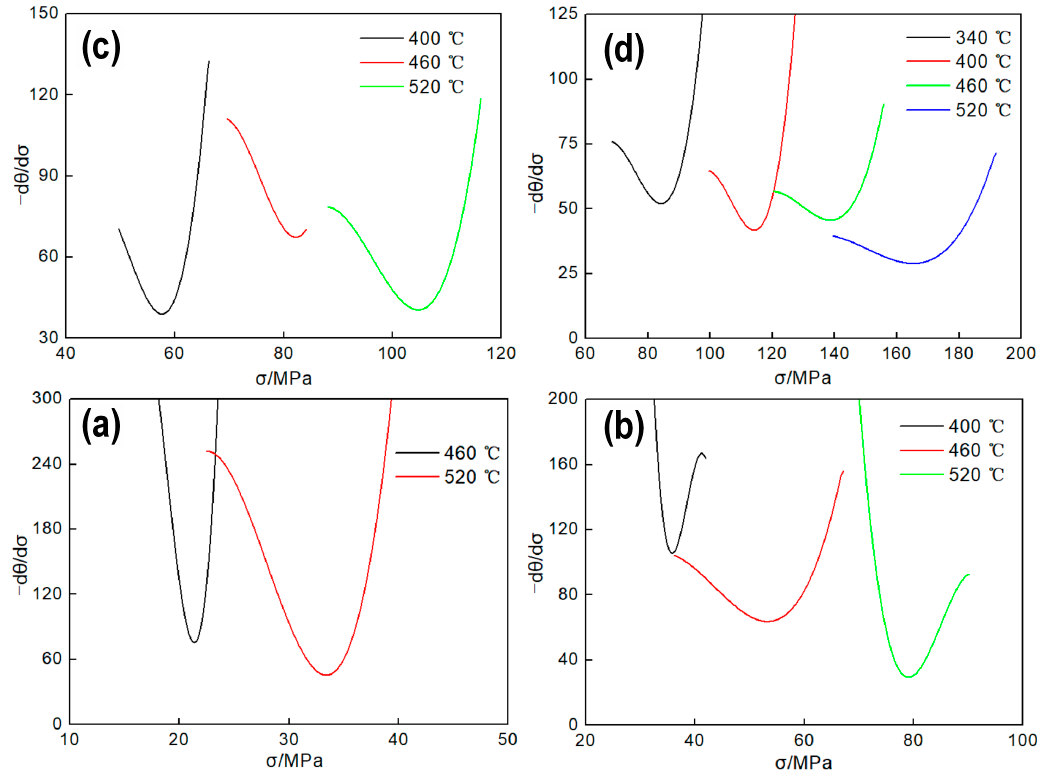
Figure 7. Relationship between strain hardening rate and flow stress of Al–4.8Mg alloy. ( a ) 0.01 s − 1 ; ( b ) 0.1 s − 1 ; ( c ) 1 s − 1 ; ( d ) 10 s − 1 .